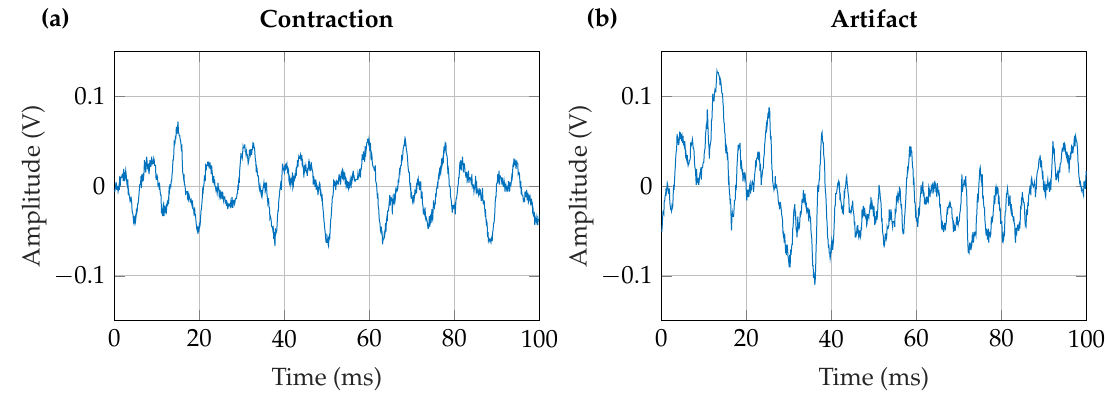
Figure 3. ( a ) Textile capacitive EMG sensing electrode. ( b ) Flexprint capacitive EMG sensing electrode. ( c ) Control of myoelectric hand prosthesis with capacitive EMG measurement setup (Adapted from Roland et al. [1]).